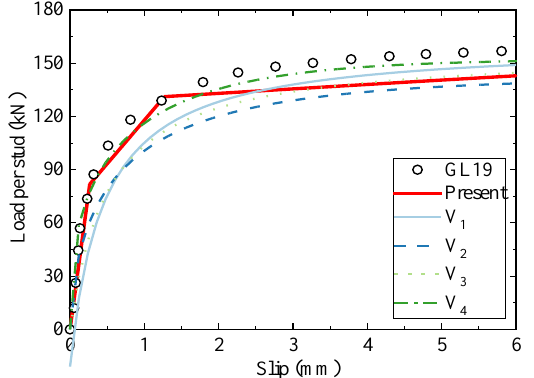
Figure 6. The comparison of load–slip curves between the test, empirical formulae, and the analytical method for GL19.